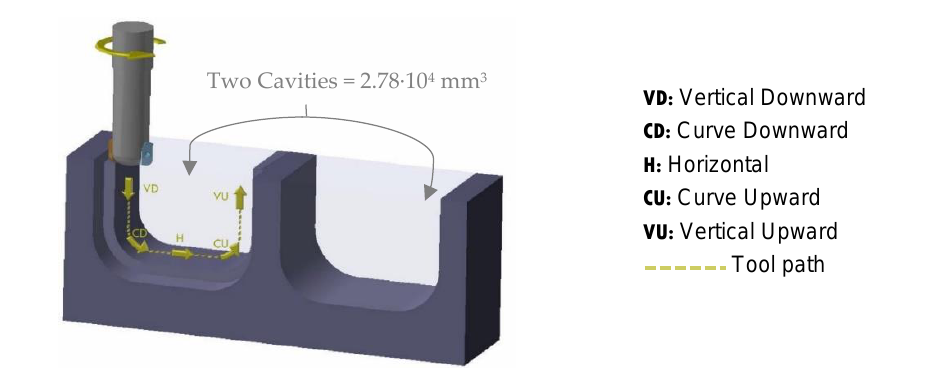
Figure 5. Machining kinematics.